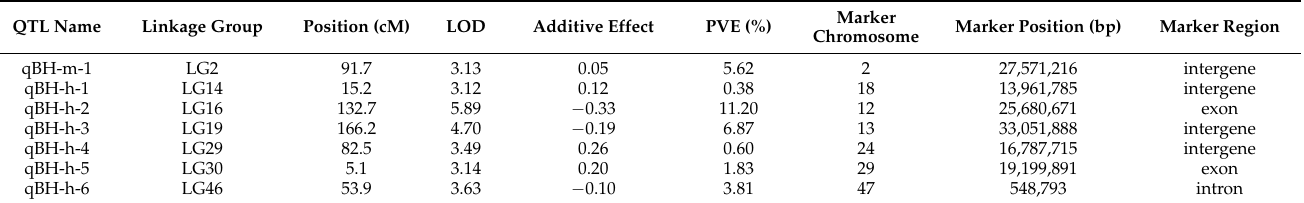
Table 3. Information on body height-related QTLs in Yellow River carp at 5–9 months after hatching.